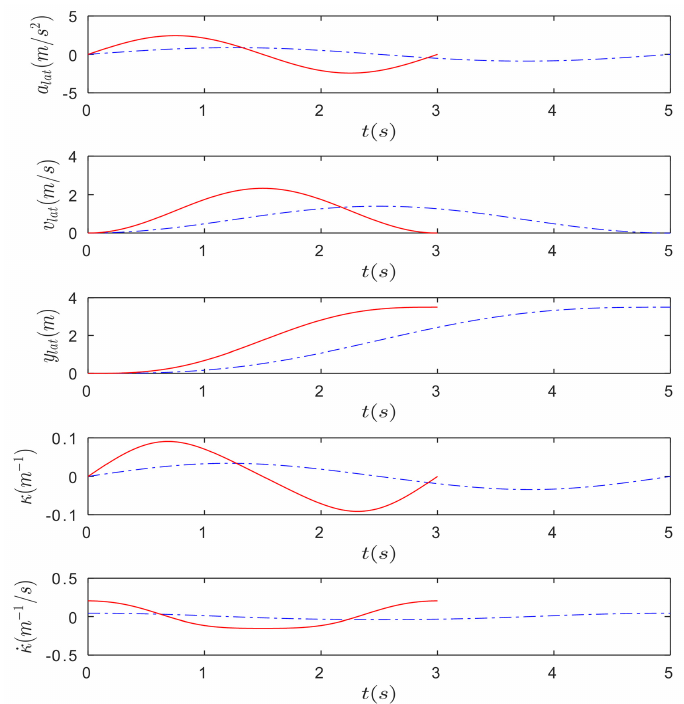
Figure 1. The lateral motion of the evasive motion model. The dashed blue line and red solid line respectively represent the values by setting t lat as 5 s and 3